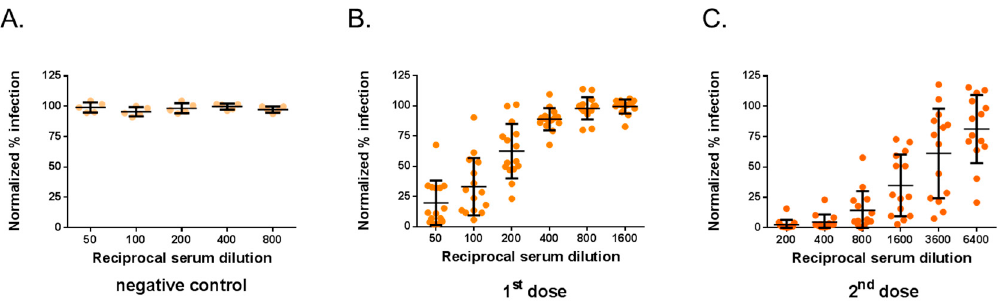
Figure 5. Flow cytometry neutralization test on A549 cells. The neutralizing ability of mouse serum specimens against ZIKV was determined by FNT on A549 cells. Samples of anti-ZIKBeHMR-2 immune sera were tested individually. Serum samples were two-fold serial diluted starting at a 1:50 dilution and mixed with an equal volume of virus sample containing 20,000 PFU of MR766 GFP . The virus-antibody mixture was added on 20,000 A549 cells grown in 96-well plates. At 20 h post-infection, the percentage of positive cells for GFP expression was determined by flow-cytometry analysis. The number of GFP-positive cells without serum was considered 100% of infectivity. The results were expressed as the percentage of GFP-positive cells in assay relative to that calculated without serum. In ( A ), The immune sera of BALB / c mice inoculated with heat-inactivated ZIKBeHMR-2 served as a negative control (negative control). In ( B ), immune sera of BALB / c mice that received a single dose of ZIKBeHMR-2 (5 log PFU) (1 st dose). In ( C ), immune sera of BALB / c mice that received two doses of ZIKBeHMR-2 (5 log PFU) with a 6-week interval (2 nd